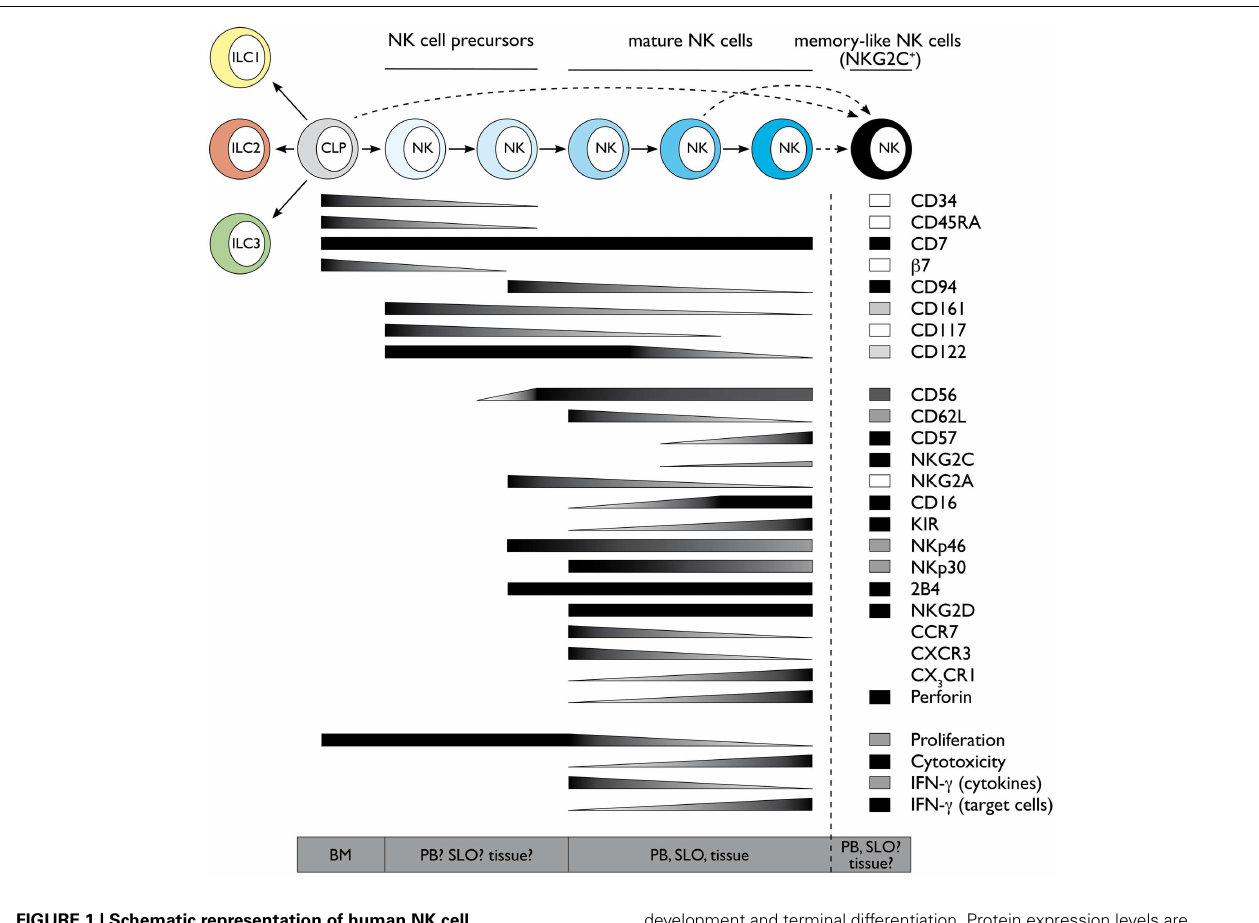
FIGURE 1 | Schematic representation of human NK cell development and terminal differentiation .The development of human NK cells from a common lymphoid progenitor over NK cell precursors to terminally differentiated NK cells is depicted from left to right.The acquisition and loss of indicated surface markers and functional properties propose a linear model of human NK cell